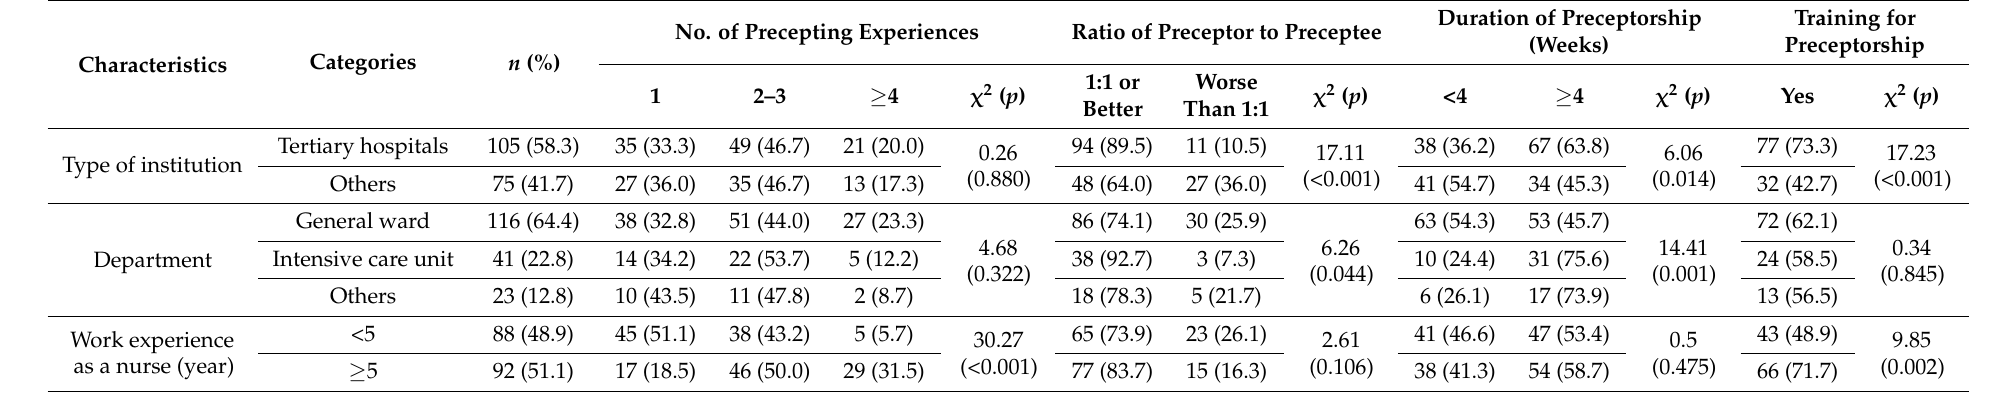
Table 1. Descriptive statistics of participants’ characteristics and experiences as preceptors ( n =